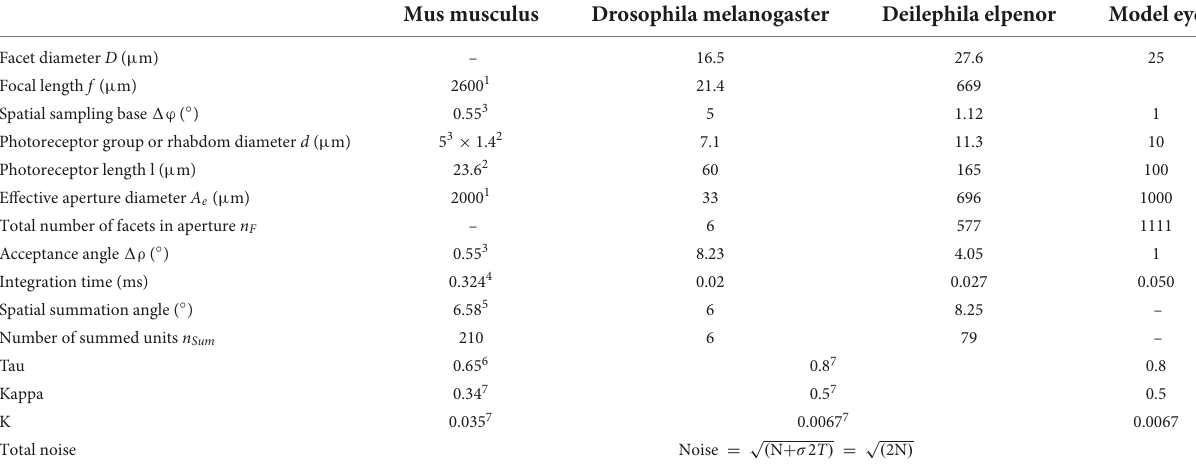
TABLE 1 Parameters of the different eye types used for photon